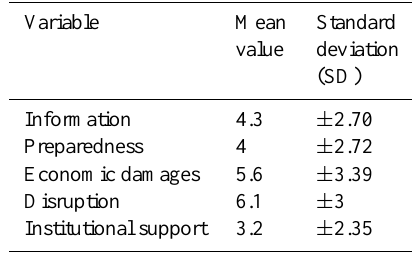
Table 1. Visual output of the key